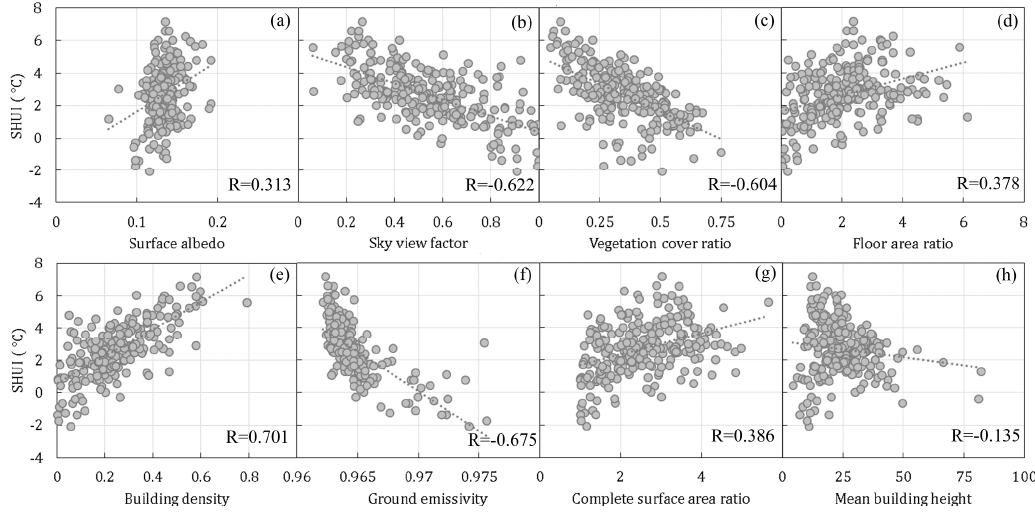
Figure 9. SUHI versus urban design factors of ( a ) surface albedo, ( b ) sky view factor, ( c ) vegetation cover ratio, ( d ) floor area ratio, ( e ) building density, ( f ) ground emissivity, and ( g ) complete surface area ratio, and ( h ) mean building height for the mixed LCZ in the central urbanized area of Guangzhou.